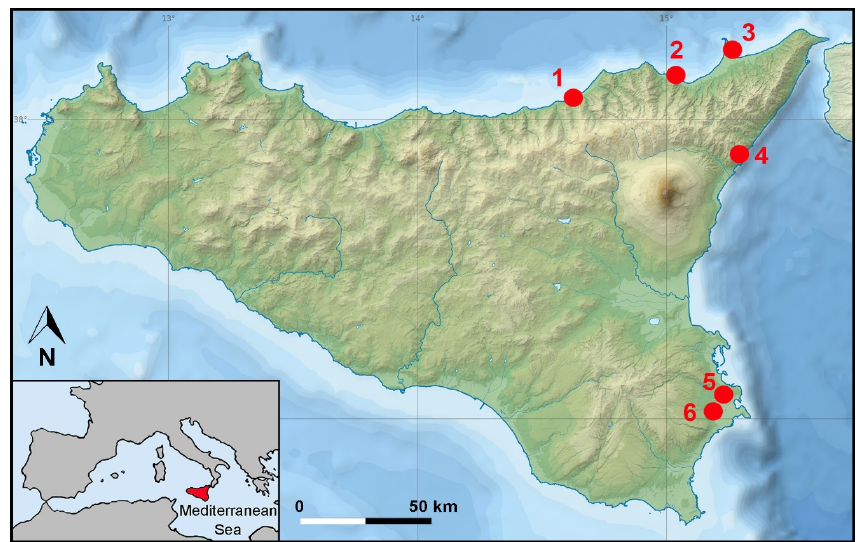
Figure 1. Location of the studied caves. (1): San Teodoro Cave; (2): Donnavilla Cave; (3): Fulco Cave; (4): Taormina Cave; (5): Tremilia Cave; (6): Spinagallo Cave. For more or less long periods, the history of these caves has been controlled by the sea flooding inside or stationing near the entrance, as testified by the presence of erosional marks, including common bivalve boreholes, marine biotic crusts such as vermetid aggre- gates, and/or layers bearing marine fossil shells. All these caves correlate with marine terraces that were forming during the intense uplift affecting eastern Sicily during the Pleistocene. Terraced sediments deposited during sea high-stands correspond to odd numbers in the marine isotopic record (Figure 2).